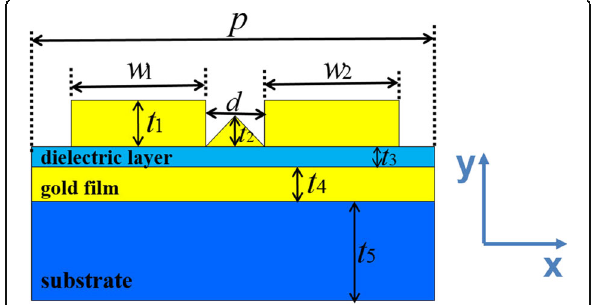
Fig. 1 Schematic of the proposed metamaterial structure of one unit